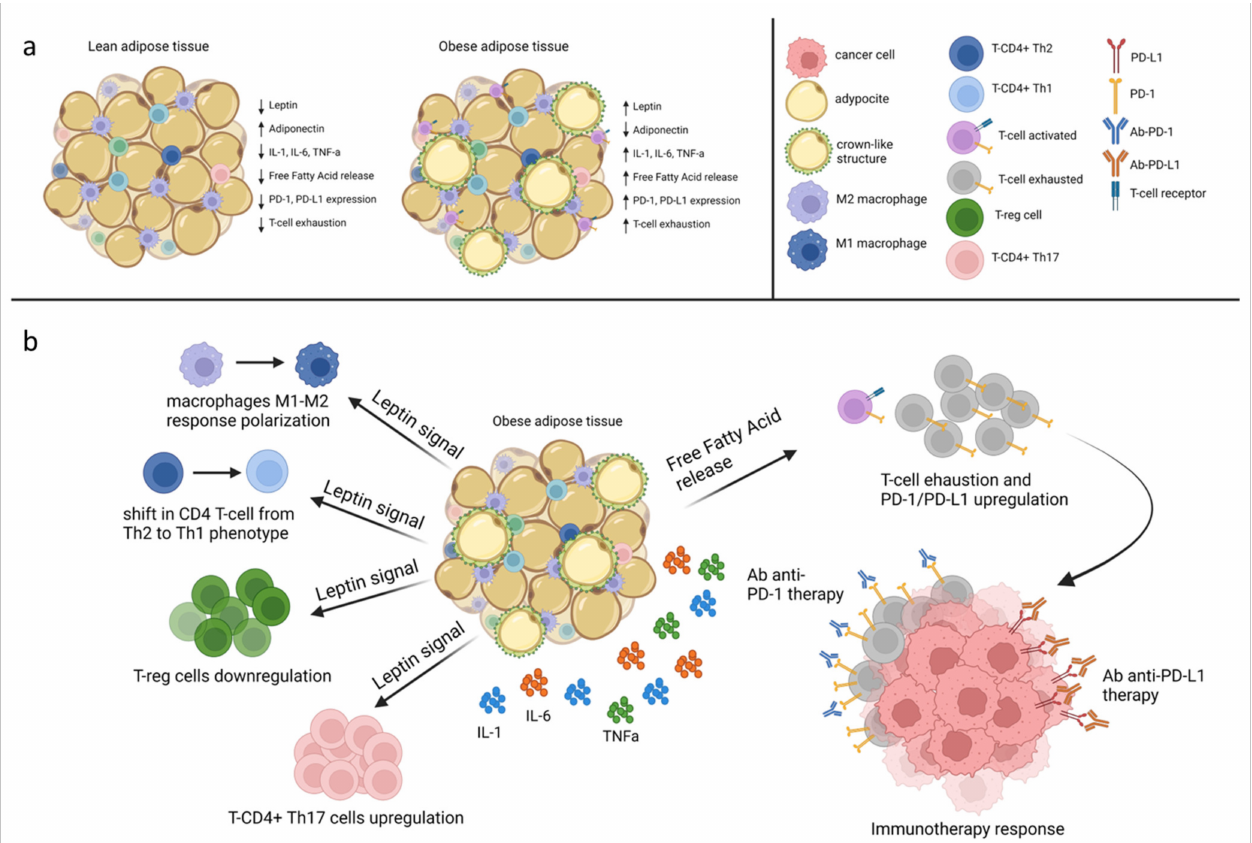
Figure 3. Obesity-related immune landscape. ( a ). Expansion of fat adipose tissue, compared to lean adipose tissue, is associated with a microenvironment proinflammatory state characterized by an imbalance of adipokines secretion and a systemic immune response reprogramming. Adipocytes’ hyperplasia and hypertrophy provoke adipose tissue macrophages (ATMs) activation resulting in the formation of typical crown-like structures (CLS). ( b ). Leptin increasing signal stimulates macrophages M1-M2 response polarization, induces a shift in CD4 T-cell from a Th2 towards Th1 phenotype, promotes T-reg cells down-regulation and T-CD4+ Th17 up-regulation. Free fatty acid (FFAs) release and antigenic chronic stimulation lead to T cell exhaustion and consequently PD-1 and PD-L1 upregulation, resulting in cancer cell immune escape. Eventually, PD-1/PD-L1 hyperexpres- sion represents a paradoxical potential target for immune-checkpoint inhibitors. Figure created in BioRender (https://biorender.com/ (accessed on 15 September